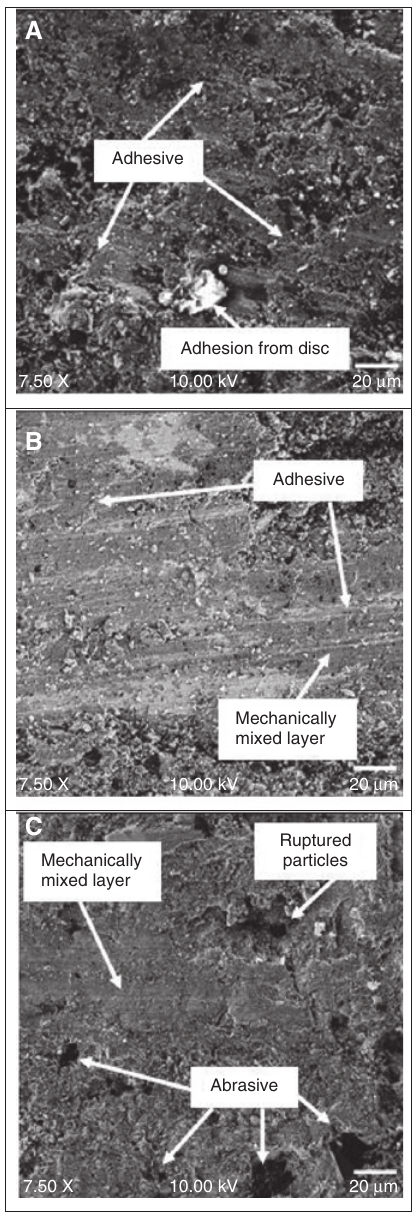
Figure 6: Worn surfaces of S1: (A) 10, (B) 20 and (C) 40 N.